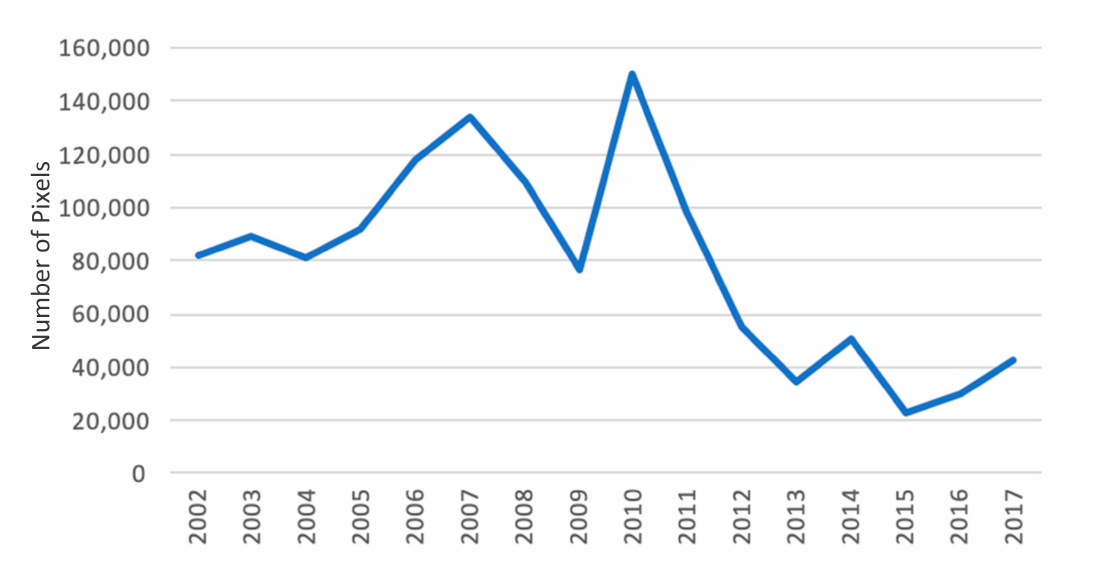
Figure 7. Yearly count of burned pixels in S ã o Paulo, from 2002 to